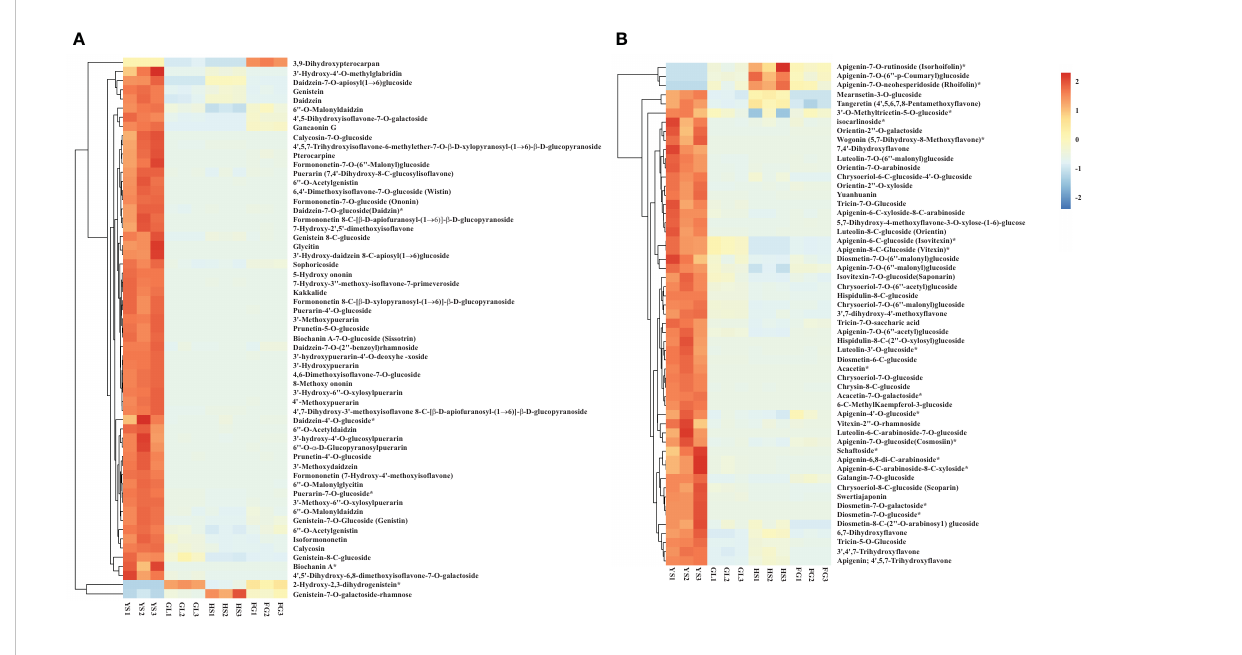
FIGURE 5 Heatmap of selected differentially accumulated metabolites. (A) iso fl avones; (B) fl avones in P. thomsonii and P. lobata . HS, FG, GL, P. thomsonii varieties; YS, P. lobata variety. The asterisk indicates that this substance has isomers.